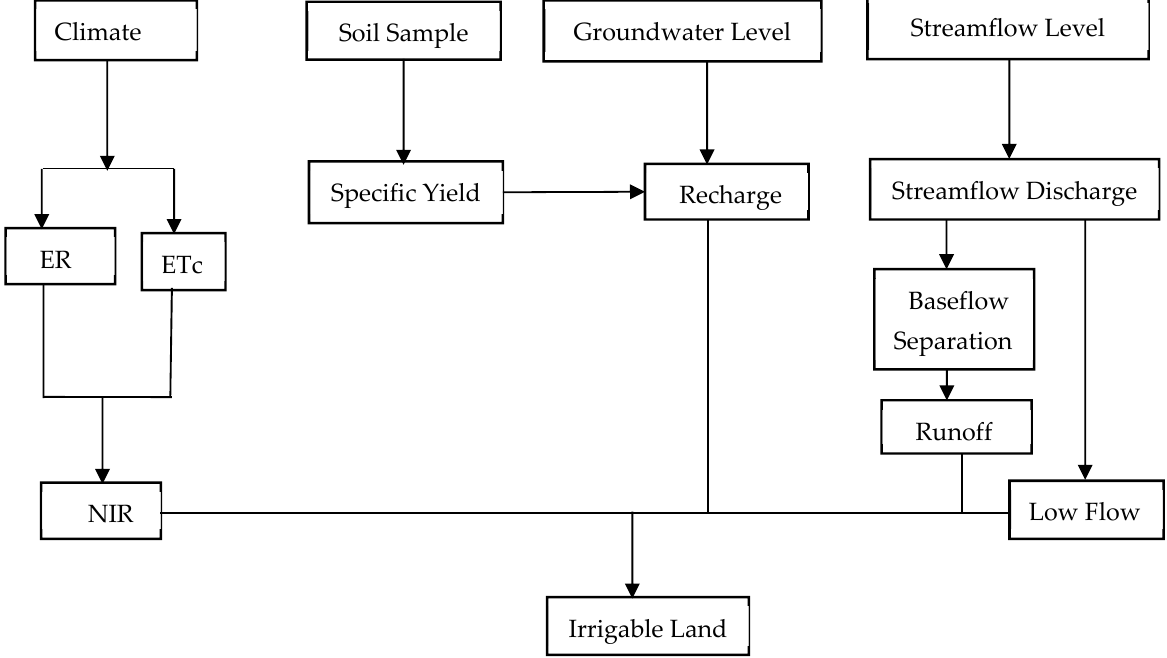
Figure 2. Overall methodology and workflow of the research. ER, ETc, and NIR are effective rainfall, crop evapotranspiration, and net irrigation requirement, respectively.